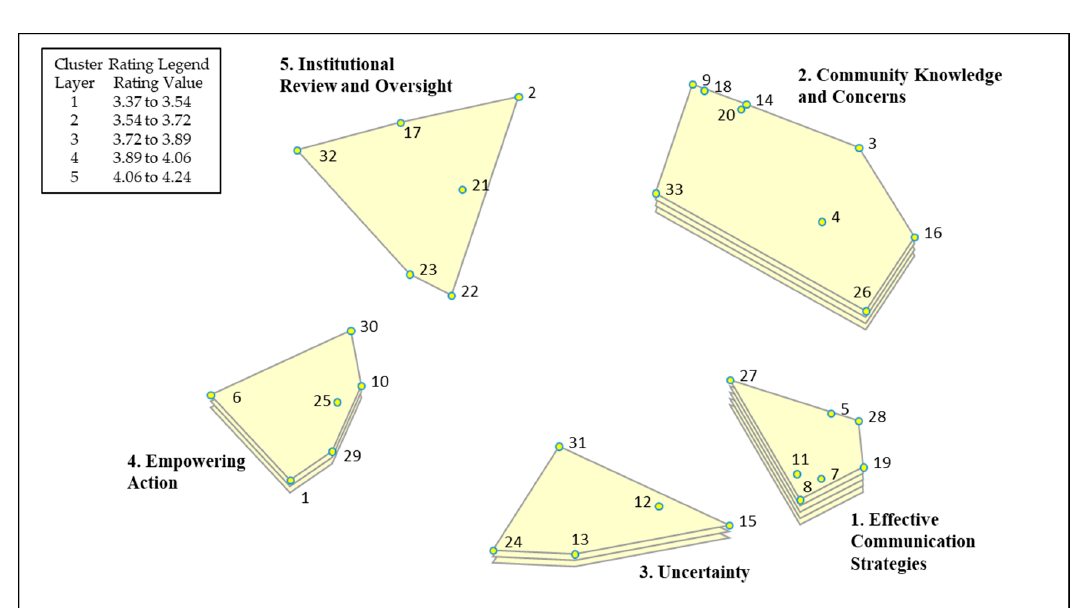
Figure 1. Report-back Cluster Rating Map. The Cluster Rating Map depicts the five report-back themes identified and selected by workshop participants, including points and statement numbers for each statement that makes up the cluster (listed in Table 1). Statements that were frequently sorted together (seen by participants as conceptually related) are placed closer to each other. The average importance rating of each cluster is illustrated by the layers of each cluster, with more layers indicating a higher average rating.